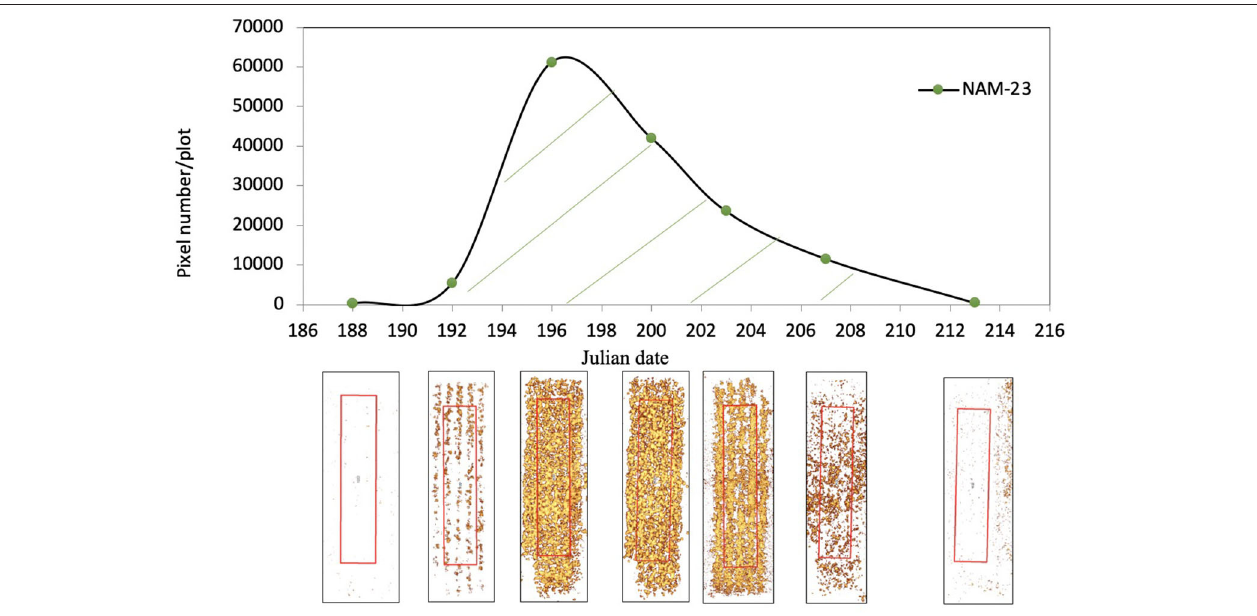
FIGURE 2 | The growth pattern of flowering progress for a Brassica napus line (NAM-23) during the flowering stage at the Agriculture and Agri-Food Canada Research Farm (52 ◦ 10’ 59.3” N, 106 ◦ 30’ 53.7” W) near Saskatoon, SK, Canada in 2017. The x-axis is the imagery acquisition date (Julian date) in 2017. The y-axis is normalized difference yellowness index (NDYI)-based pixel number per plot. A solid curve line is the flowering progress trend of NAM-23. Seven points on the progress curve line represent NDYI-based pixel number per plot at seven imagery acquisition dates. Seven pictures under each point are corresponding false-color images after thresholding with flowers highlighted in yellow. The region of interest was highlighted in red.